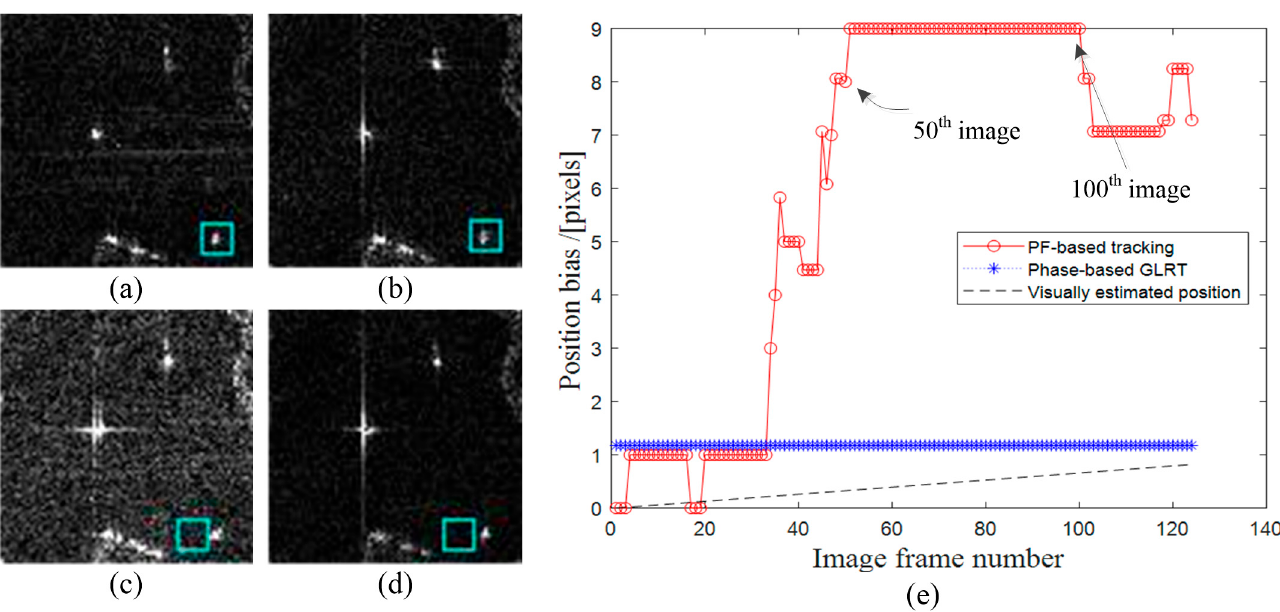
Figure 9. Results of applying the PF-based tracker to the Lvshungang image sequences. In ( a ), the first image, the cyan square is specified to indicate the centroid of the moving vessel accurately. In ( b ), the 10th image, the target can still be tracked. In ( c ), the 50th image, a location variation can be visually observed. In ( d ), the 100th image, the cyan square cannot indicate the moving target centroid, with larger position bias. ( e ) Benchmark position estimation accuracy of the PF-based tracking and phased-based GLRT method proposed in this article, wherein the visually estimated position is approximately set as 0 during the position bias computation.